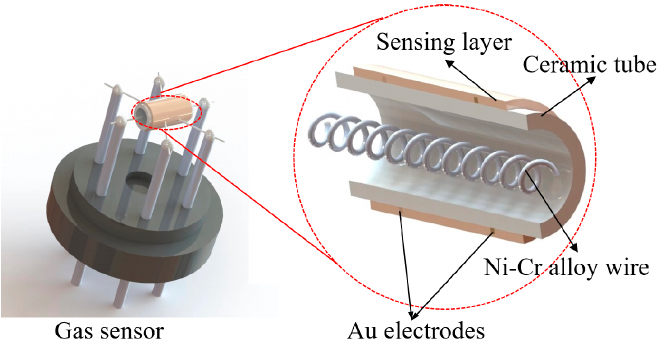
Figure 1. Schematic diagram of gas sensor device. 116